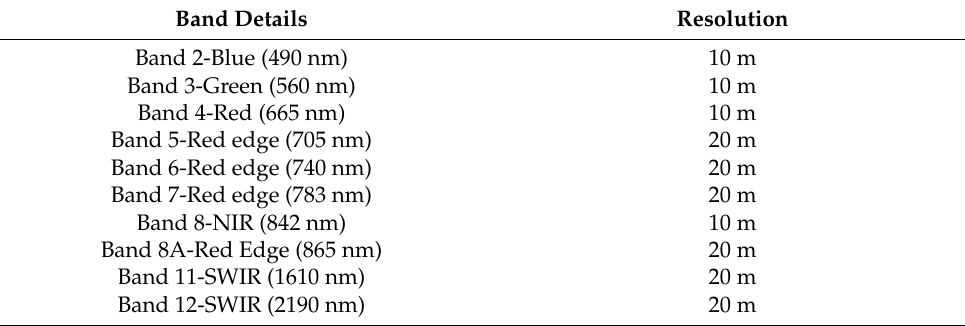
Table 2. Bands of MSI sensor onboard Sentinel 2 used in the